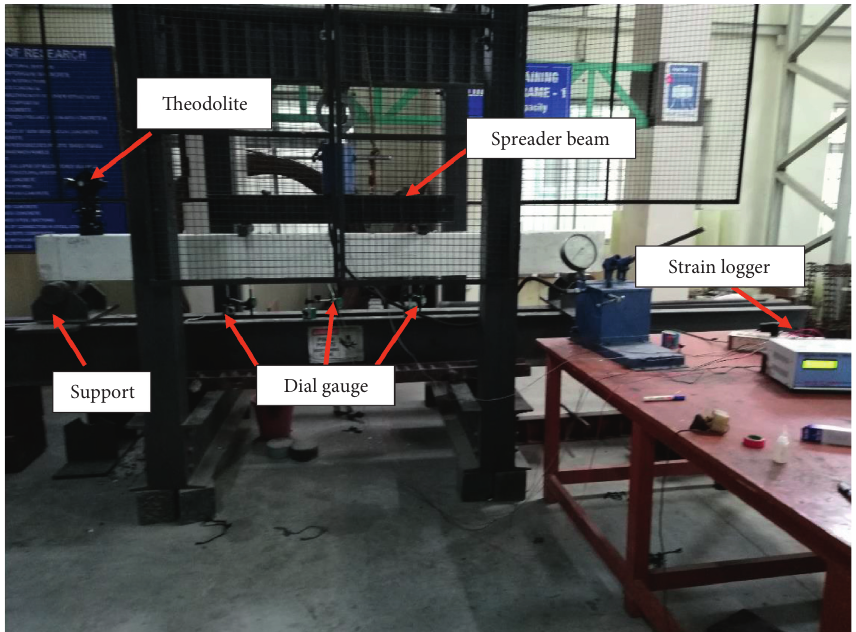
Figure 6: Test setup in the loading frame for the